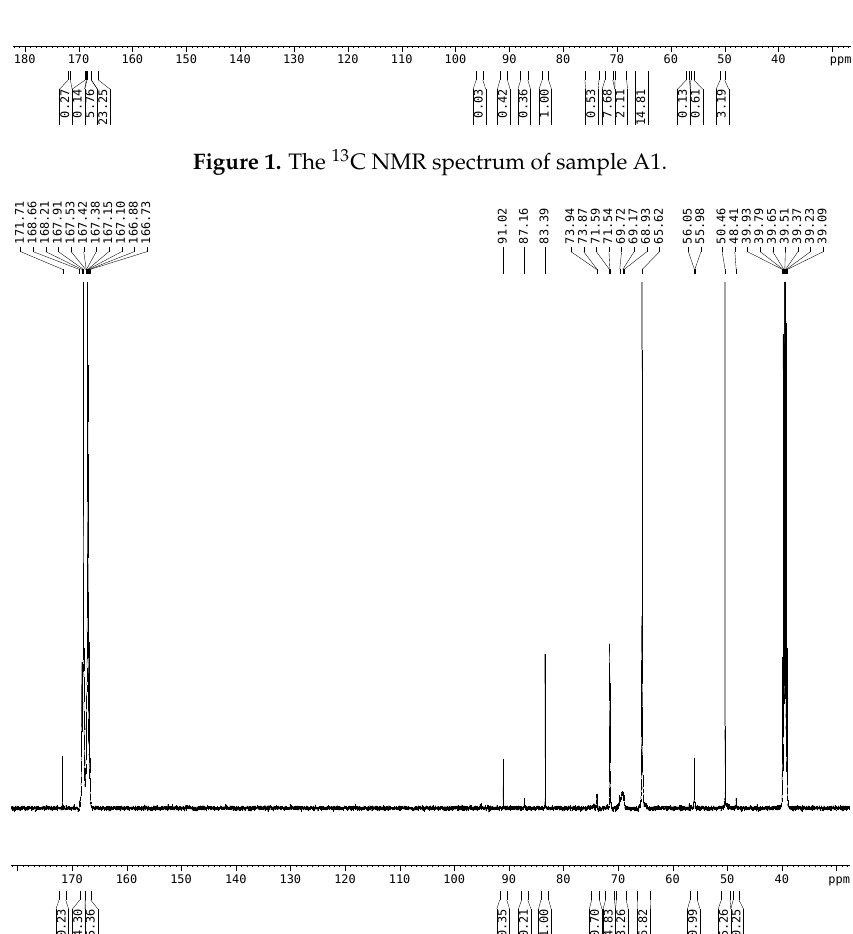
Figure 1. The 13 C NMR spectrum of sample A1.